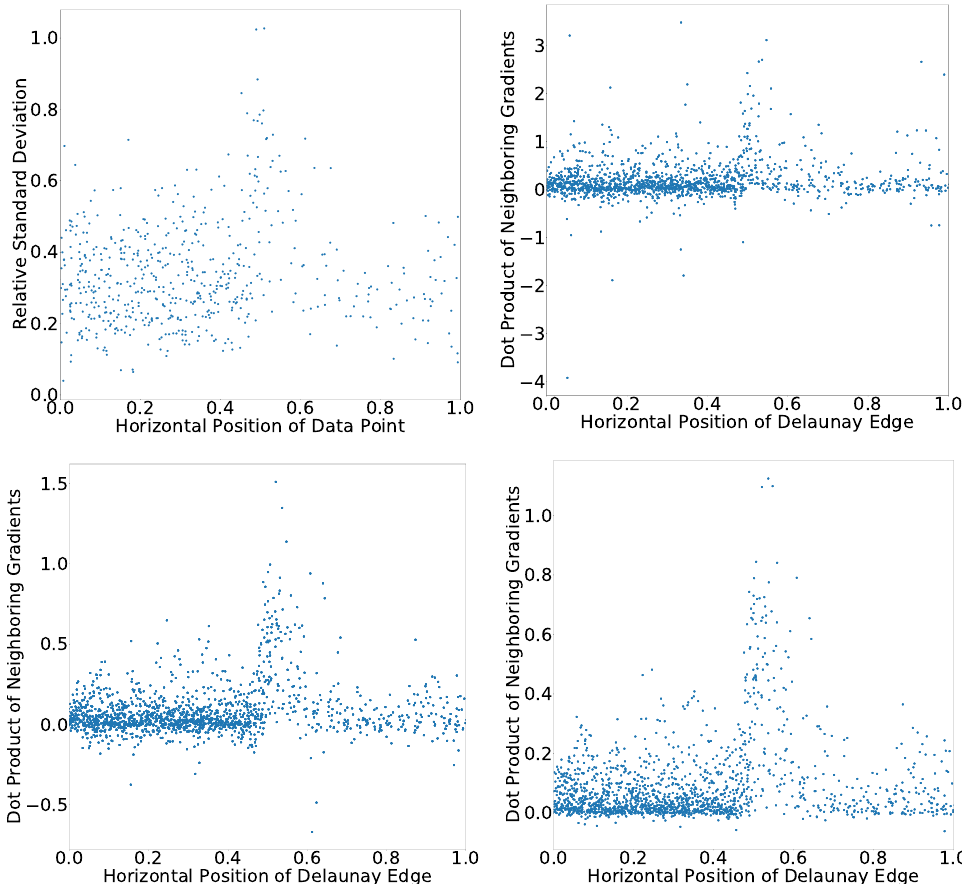
Figure 12 . Scatter plots of different tagging variables discussed in the text versus the horizontal position of the corresponding element in the tessellation. The upper left panel shows the relative standard deviation ¯ σ i defined in (3.3) versus the horizontal position x i of the generator point P i . The other three panels show dot products of different versions of neighboring gradient vectors versus the horizontal position ( x i + x j ) / 2 of the midpoint of the respective Delaunay edge D αβ : the ˜ ~G ˜ ~G rescaled gradients α · β (upper right panel), the Voronoi-averaged gradients h left panel) and the Delaunay-averaged gradients h ~G i α · h ~G i β (lower right panel).